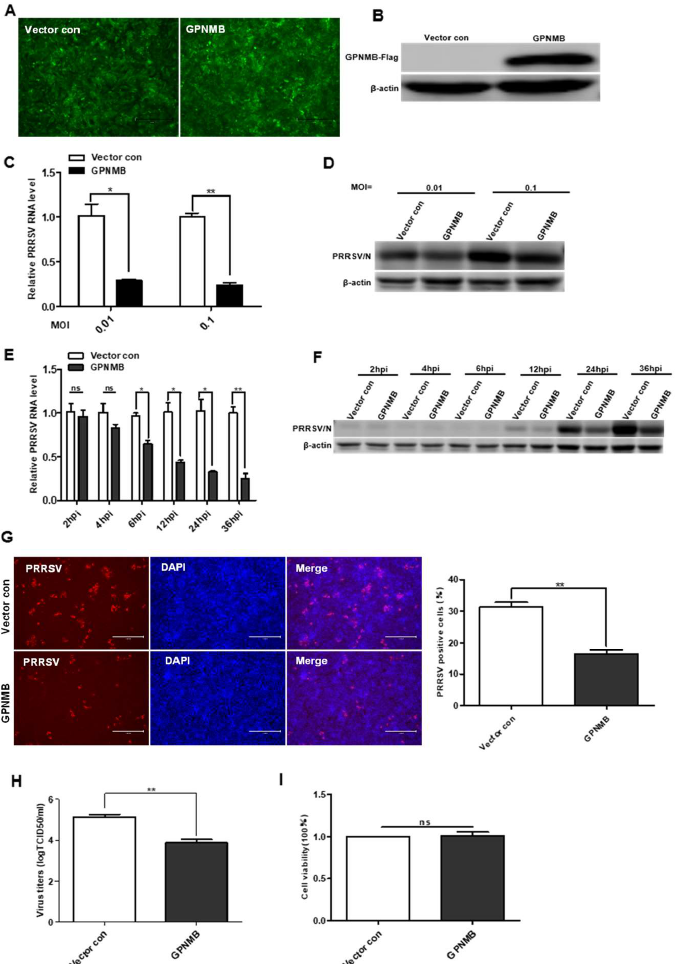
Figure 3. Overexpression of GPNMB inhibits PRRSV infection. ( A ) Immortalized PAMs were trans- duced with a bicistronic lentivirus vector expressing ZsGreen alone (vector control) or GPNMB plus ZsGreen as described in Materials and Methods. ( B ) Western blot analyses detected the protein level of GPNMB in cells infected with the GPNMB overexpression lentivirus. ( C – H ) GPNMB overexpres- sion inhibits PRRSV infection. The GPNMB-overexpressing PAMs and the vector control were in- fected with the PRRSV at different MOI, respectively. The levels of viral RNA and viral protein were determined by qPCR and Western blot ( C , D ); The GPNMB-overexpressing PAMs and the vector control were exposed to PRRSV at an MOI of 0.1, and samples were obtained at different time points. The levels of viral RNA and viral protein were determined by qPCR and Western blot ( E , F ); Cells were infected with PRRSV at an MOI of 0.1 for 24 h. Cell monolayers were fixed and examined for virus infection by IFA ( G ), and virus titers were evaluated with TCID50 ( H ). ( I ) CCK8 assay assessed the proliferation ability of GPNMB-overexpressed PAMs. Results are representative of three inde- pendent experiments (means ± SD). ns p > 0.05; * p < 0.05; ** p < 0.01. The p -value was calculated using Student’s t -test.